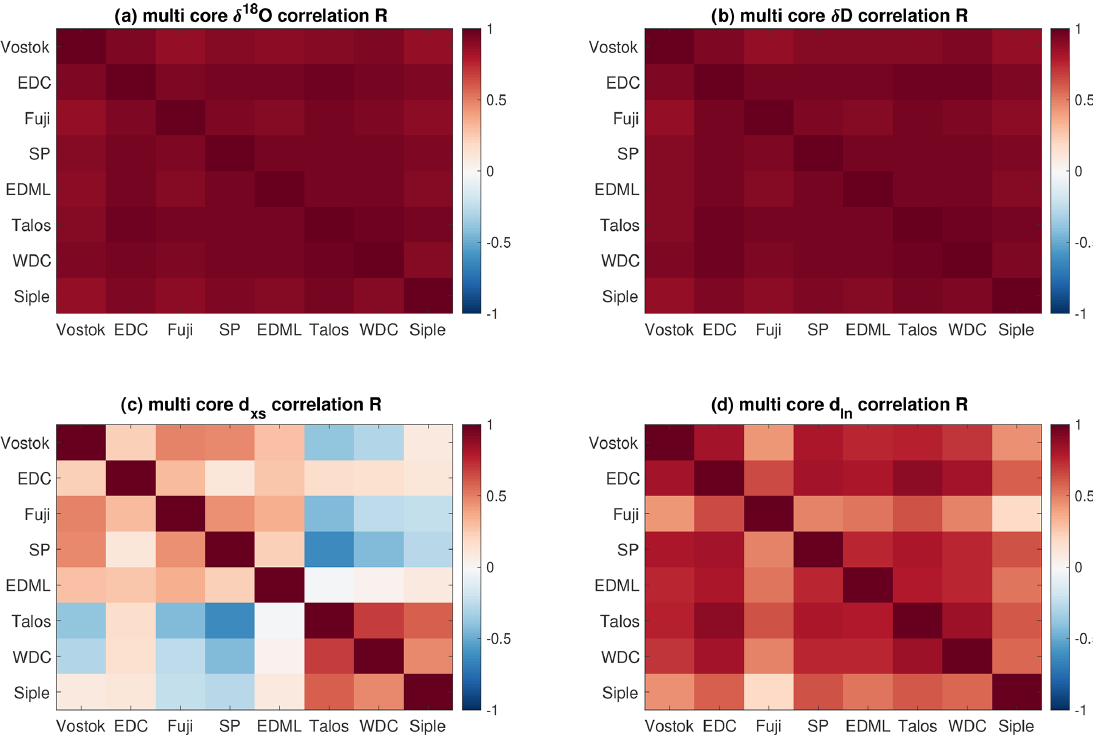
Figure A23. Correlation matrices for (a) δ 18 O, (b) δ D, (c) d xs , and (d) d ln among all core sites. All records are ordered by their approximate modern surface temperature.